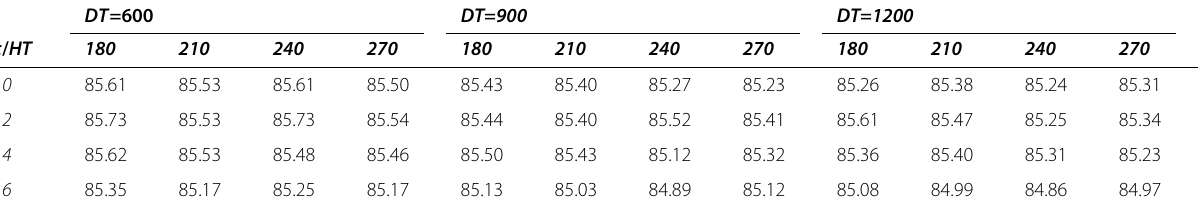
Table 2 The ACC (%) of classifiers with different values of c , HT , and DT